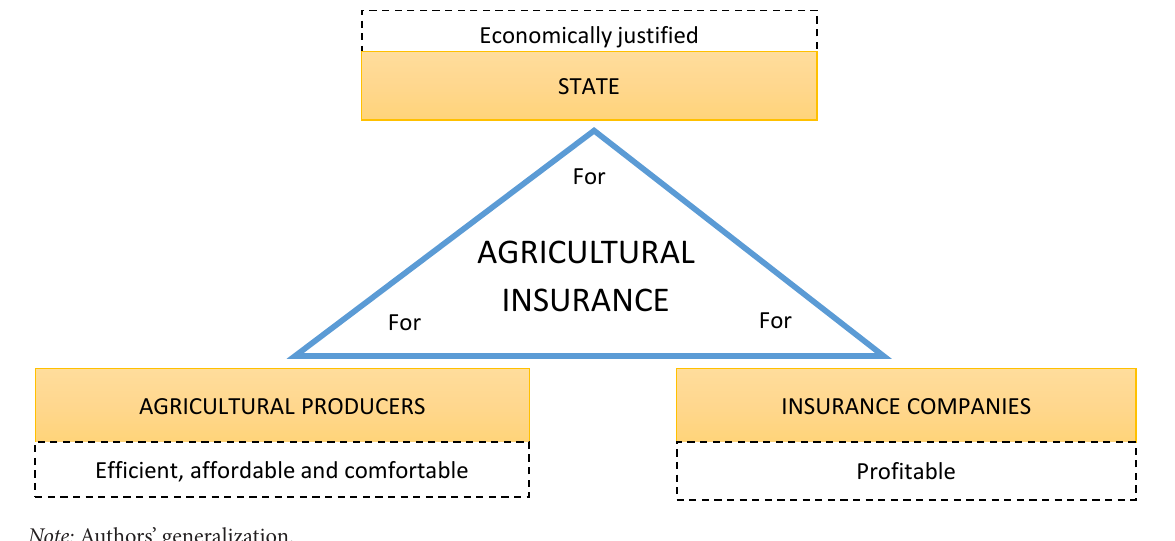
Note: Authors’ Figure 9. Dominates of the agricultural insurance direction for different entities